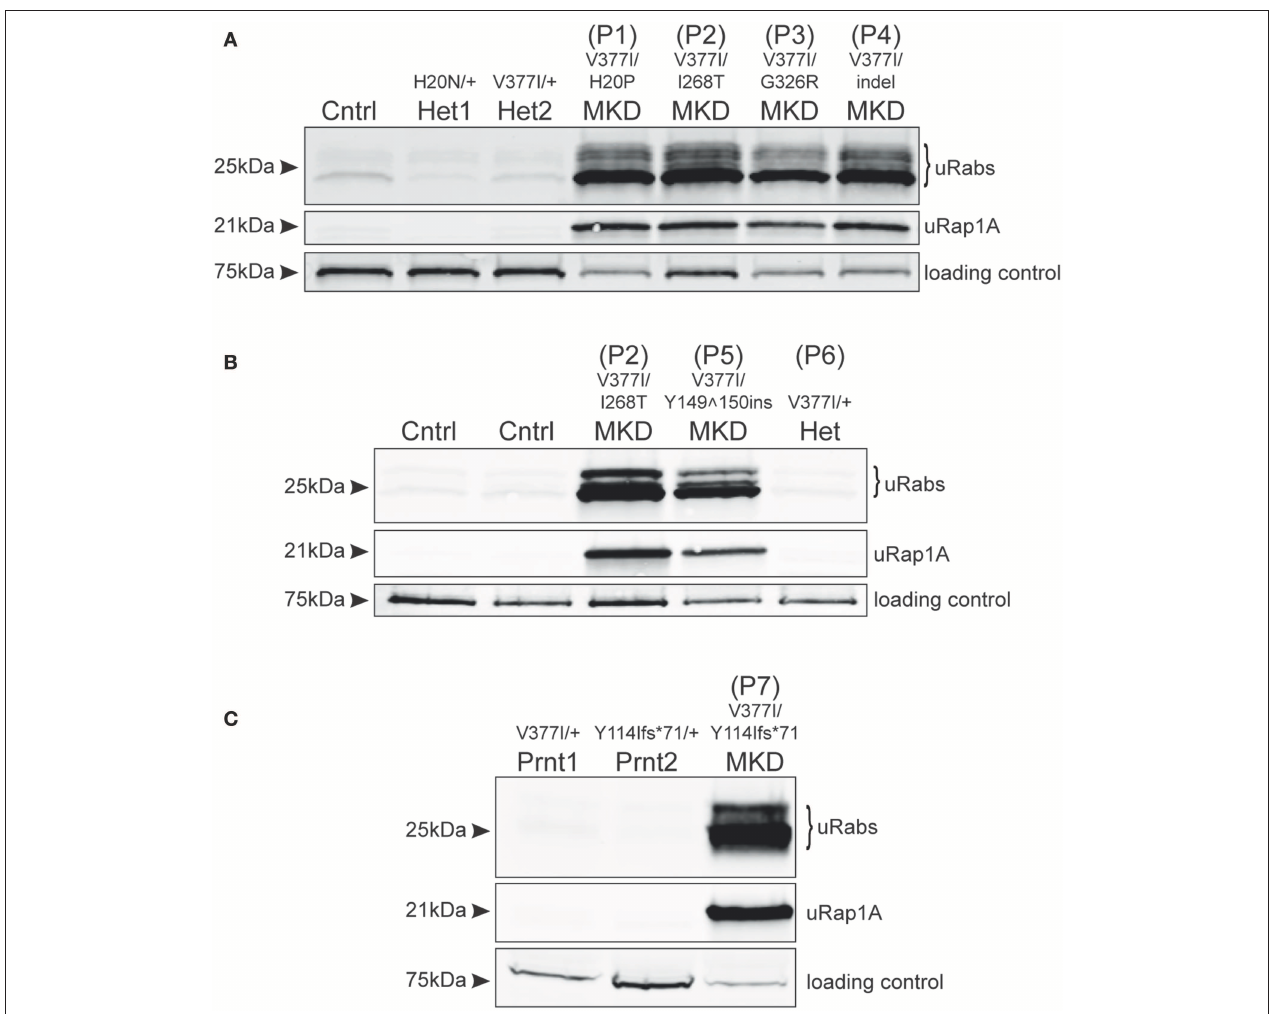
FIGURE 1 | Defective protein prenylation in PBMCs is detected consistently in patients with MKD. (A) PBMCs from four adult, compound heterozygous MKD patients (P1–P4) have clear accumulation of unprenylated Rab GTPases (uRabs) and unprenylated Rap1A (uRap1) compared to a healthy control (Cntrl) and 2 heterozygous individuals (Het1,2). (B) PBMCs from a young adult patient with MKD (P5) show accumulation of unprenylated Rab and Rap1A GTPases compared to 2 healthy controls (Cntrl) and a heterozygous (Het) individual (P6) with undiagnosed inflammatory disease. Patient P2 is also shown alongside for comparison. (C) A child